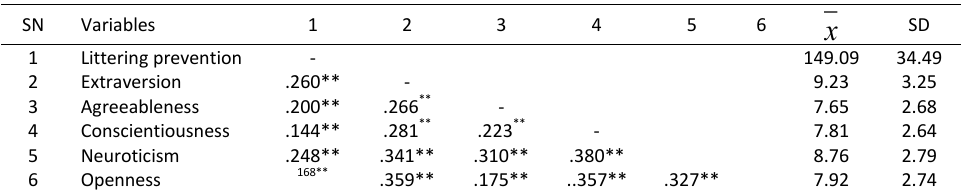
Table 1: Correlation matrix showing relationship between personality traits and Littering prevention SN Variables 1